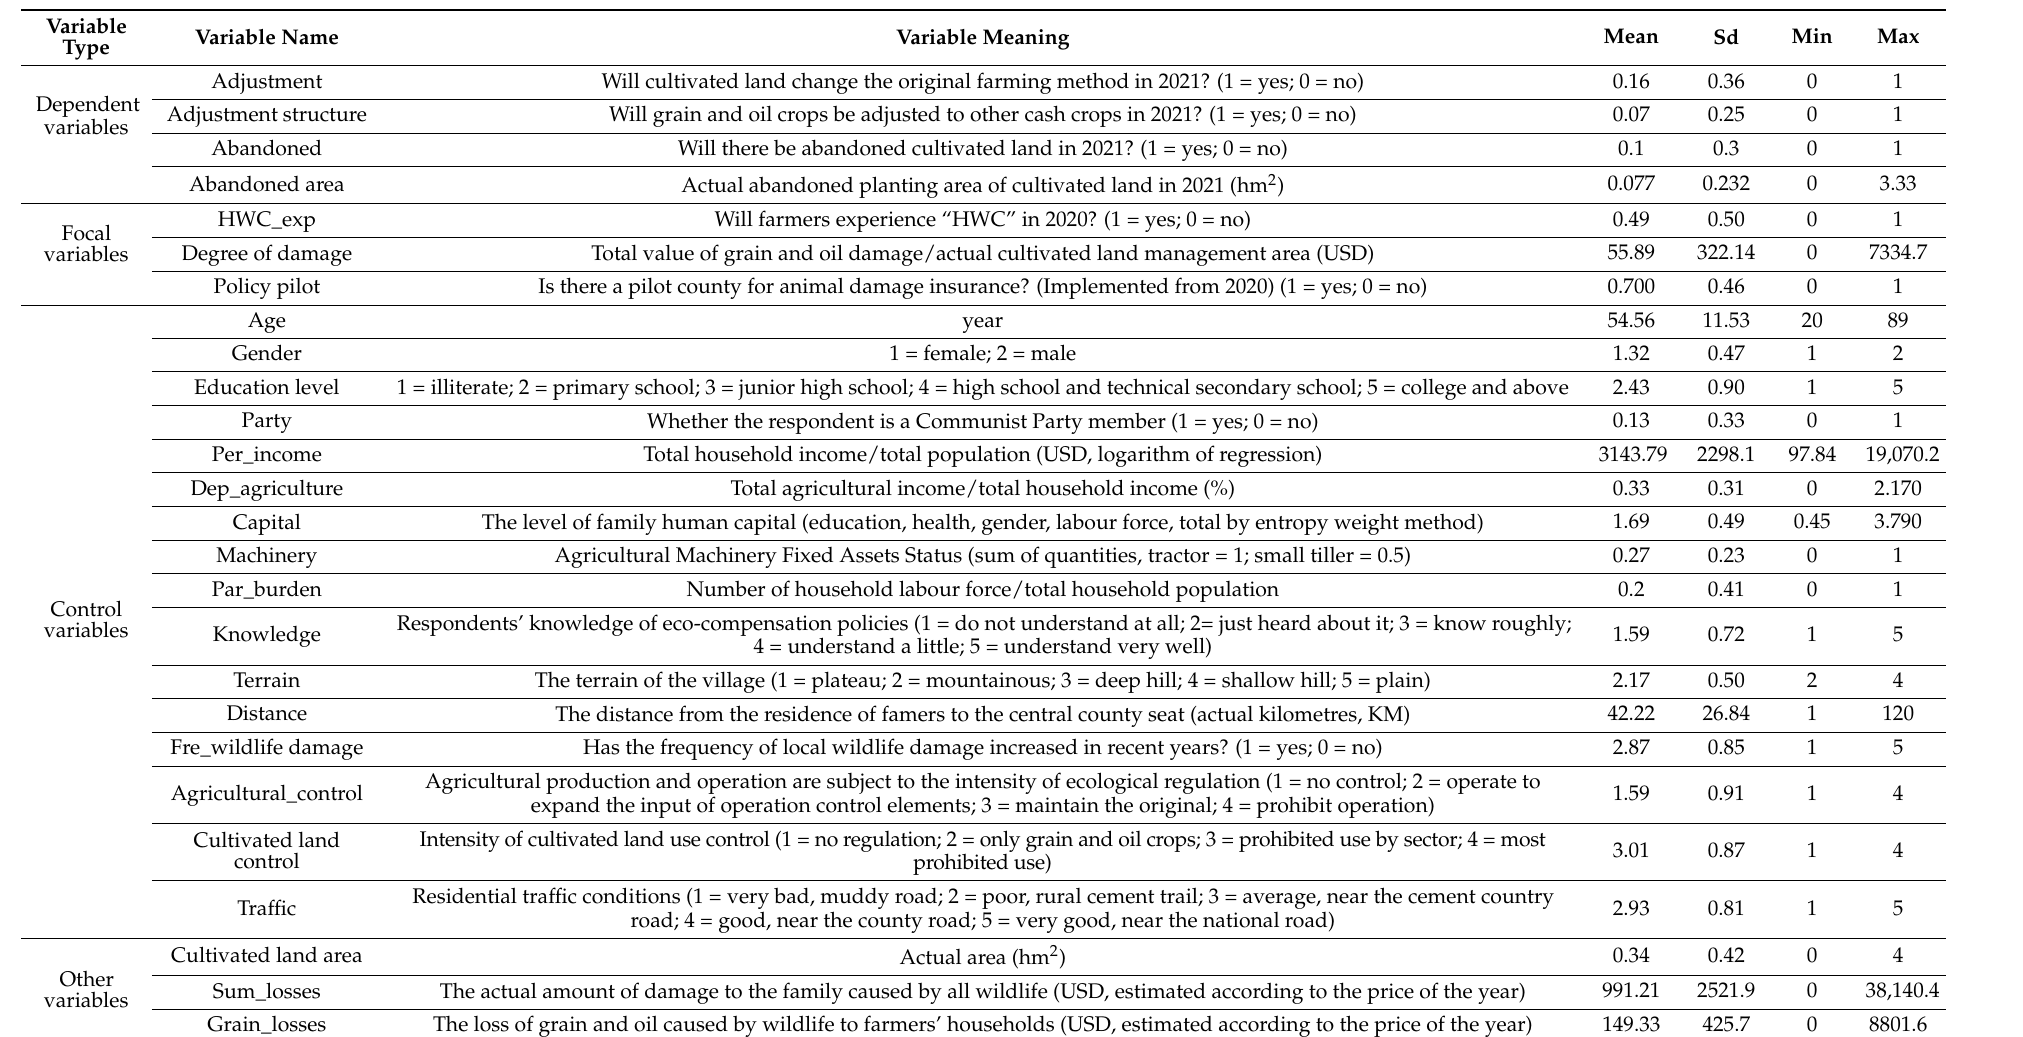
Table 1. Empirical variables’ design, variables’ meaning or calculation method, and variables’ basic